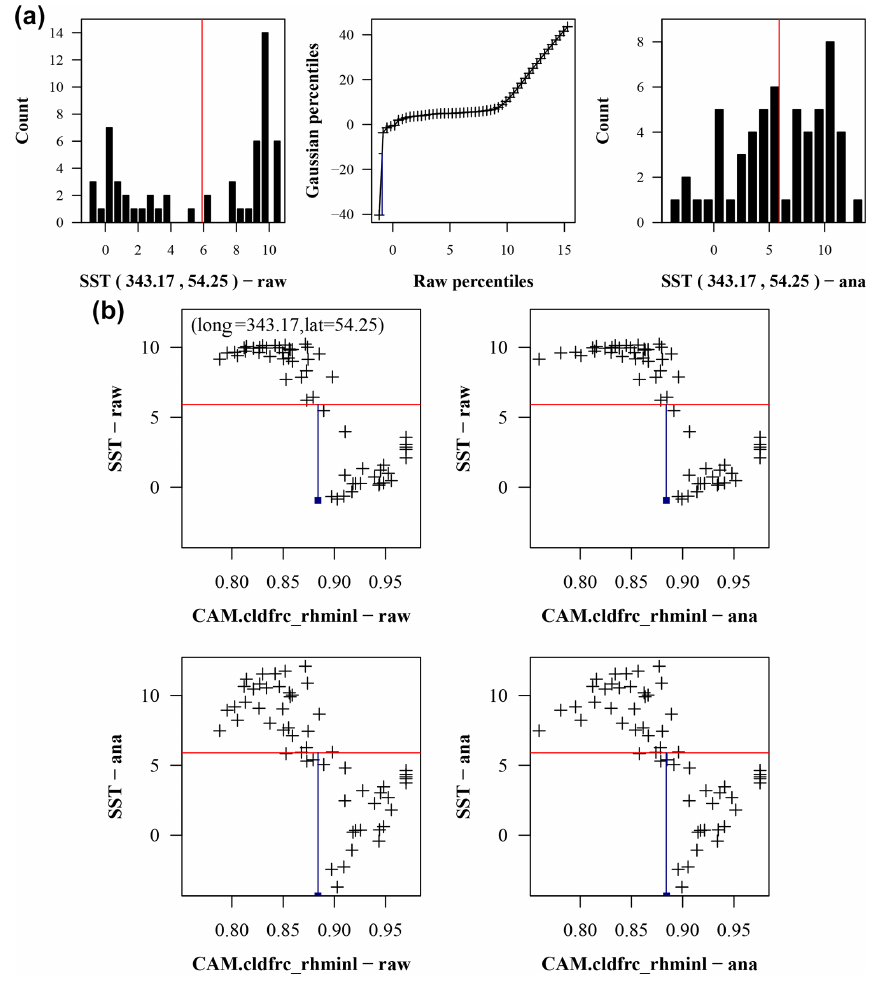
Figure 4. CESM experiment. Example of Gaussian anamorphosis transformation in a control variable (minimum relative humidity for high stable cloud formation) and the sea surface temperature (SST) for both the model equivalent of the observations and the observation (transformation details in text) at a location (343.17 ◦ E, 54.25 ◦ N; see Fig. 5) in the North Atlantic, where an apparent switch in SST takes place. (a) The anamorphosis for the SST at the location; the left panel shows the histogram of the original (raw) variable, the middle panel shows the empirical piecewise linear transformation which maps the raw variable percentiles into those of a normal variable with the two first moments (mean and standard deviation) preserved as those in the raw variable, and the right panel shows the histogram of the anamorphosed variable. (b) Scatterplots between the two variables in (a) for the original variables: cases in which only one is transformed and the case with both variables transformed. Vertical red lines in (a) and horizontal lines in (b) indicate the mean of the model background SST. Blue squares indicate observations, vertically placed and connected with the mean of the control